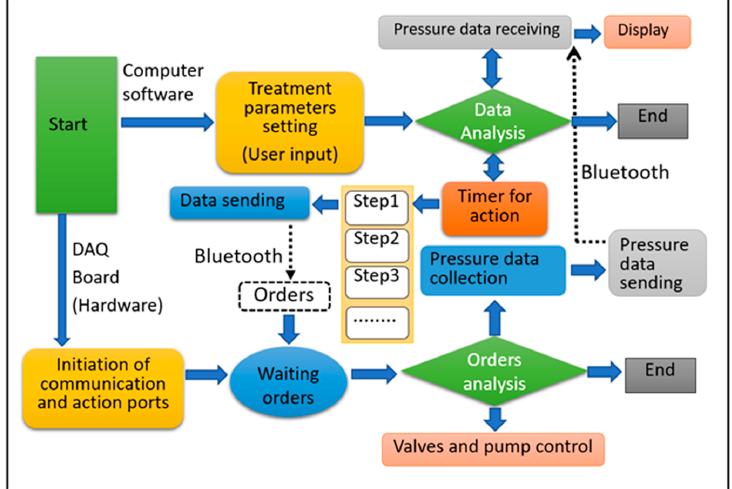
Figure 8. The hard and smooth real-time sections of the developed IPC-lower limb pressure monitoring system.